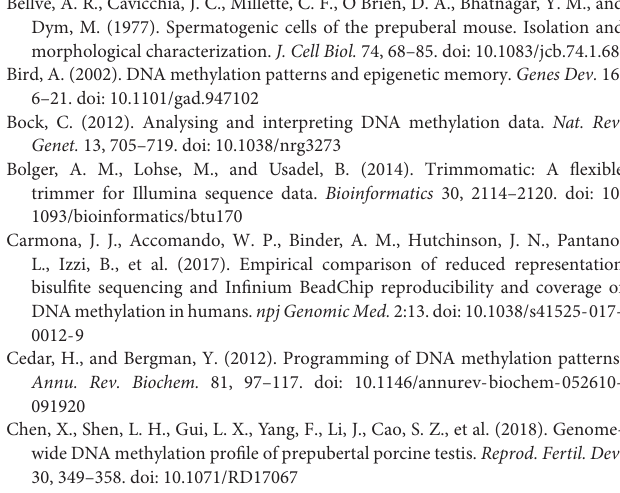
FIGURE S1 | Histograms of log10 of read coverage per CpG site. FIGURE S2 | Correlation analysis of the global CpG methylation patterns among nine samples. Note: Colors in the scatter plot indicate the number of CpG sites with identical methylation pattern (methylated or non-methylated): yellow denotes many correlations, blue denotes lack of correlation and green denotes different methylation patterns. Numbers in the upper right side represent the pairwise Pearson’s correlation scores. Histograms on the diagonal are methylation distribution per CpG site for each sample. FIGURE S3 | Regression of densities of genes, CpG islands and CpG island shores on methylation levels from one sample, all counted by 1 Mb windows. TABLE S1 | Total number of aligned cytosine methylation in different contexts. TABLE S2 | Statistics of coverage and methylation rates in CpG context. TABLE S3 | Regression and correlation analysis of densities of genes, CpG islands and CpG island shores on methylation levels, all counted by 1 Mb windows. TABLE S4 | Significant pathways ( P <